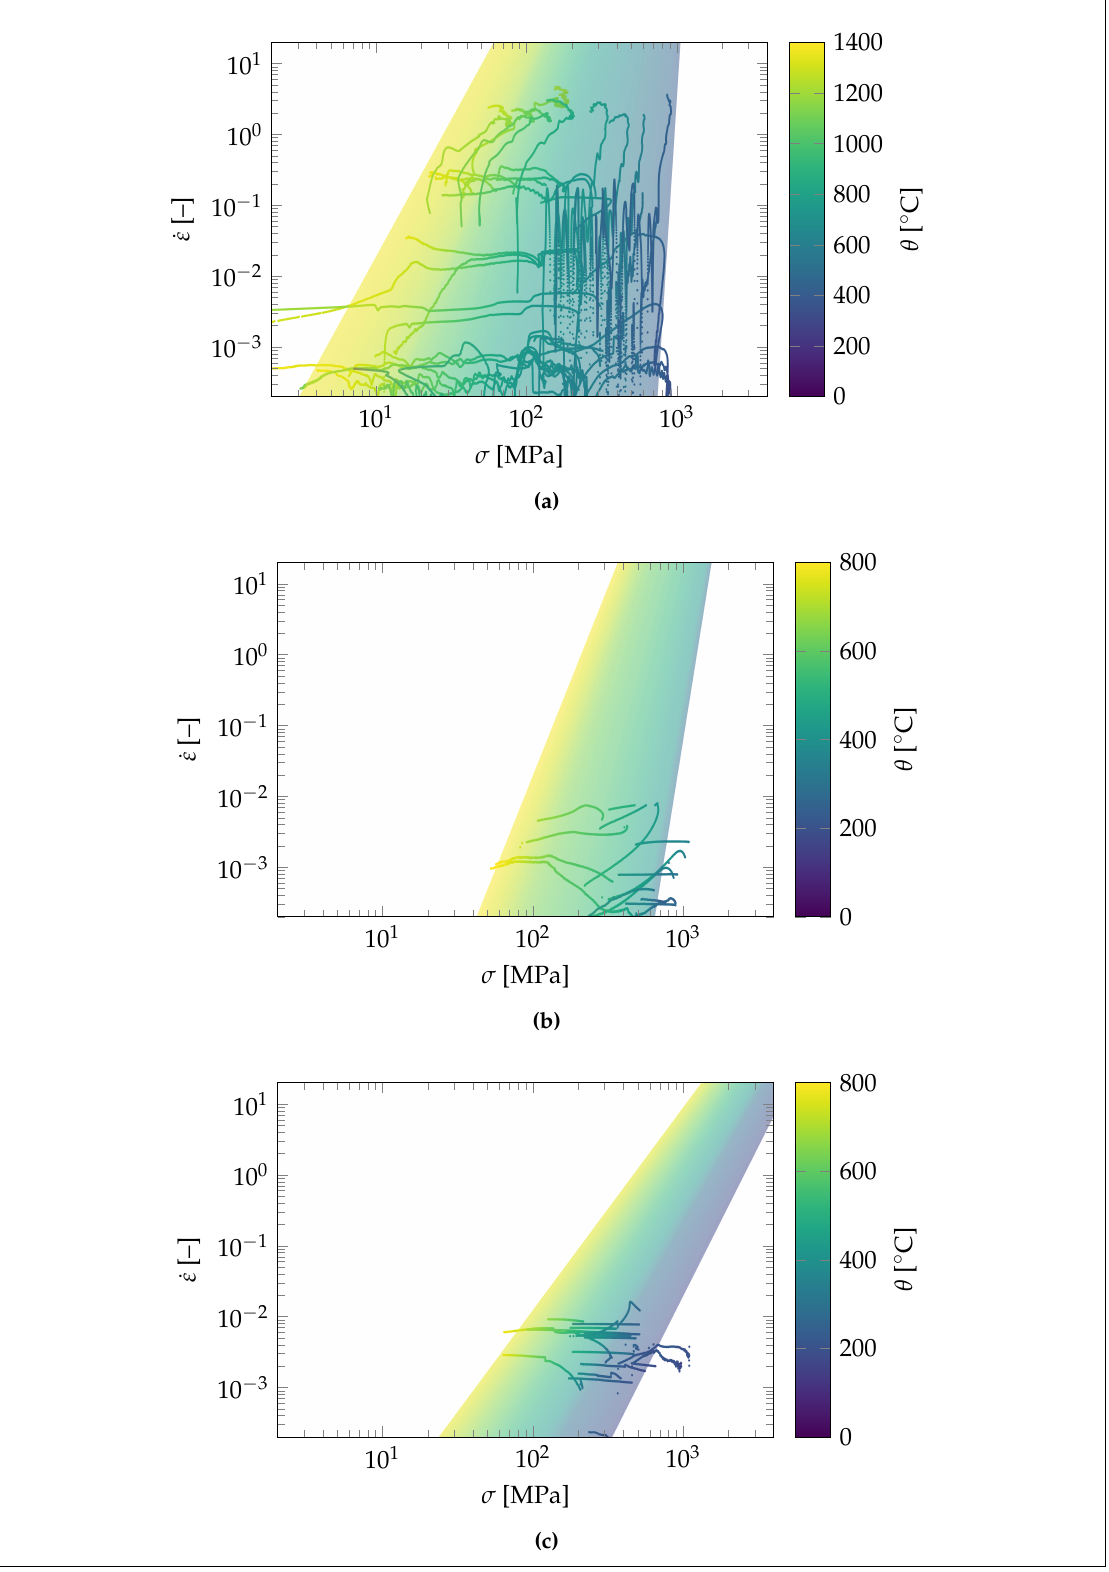
Figure 5. Flow properties examined ( a ) during heating, ( b ) at 5 K/s cooling, ( c ) at 30 K/s cooling; The surface plots represent the fitted consistently assessed Carreau fluid models for each